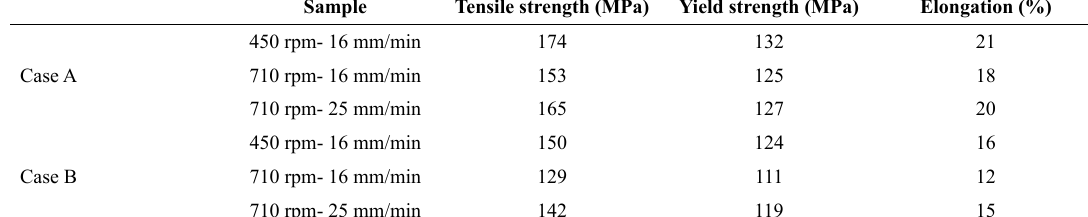
Table 3. Tensile strength of lap shear specimens